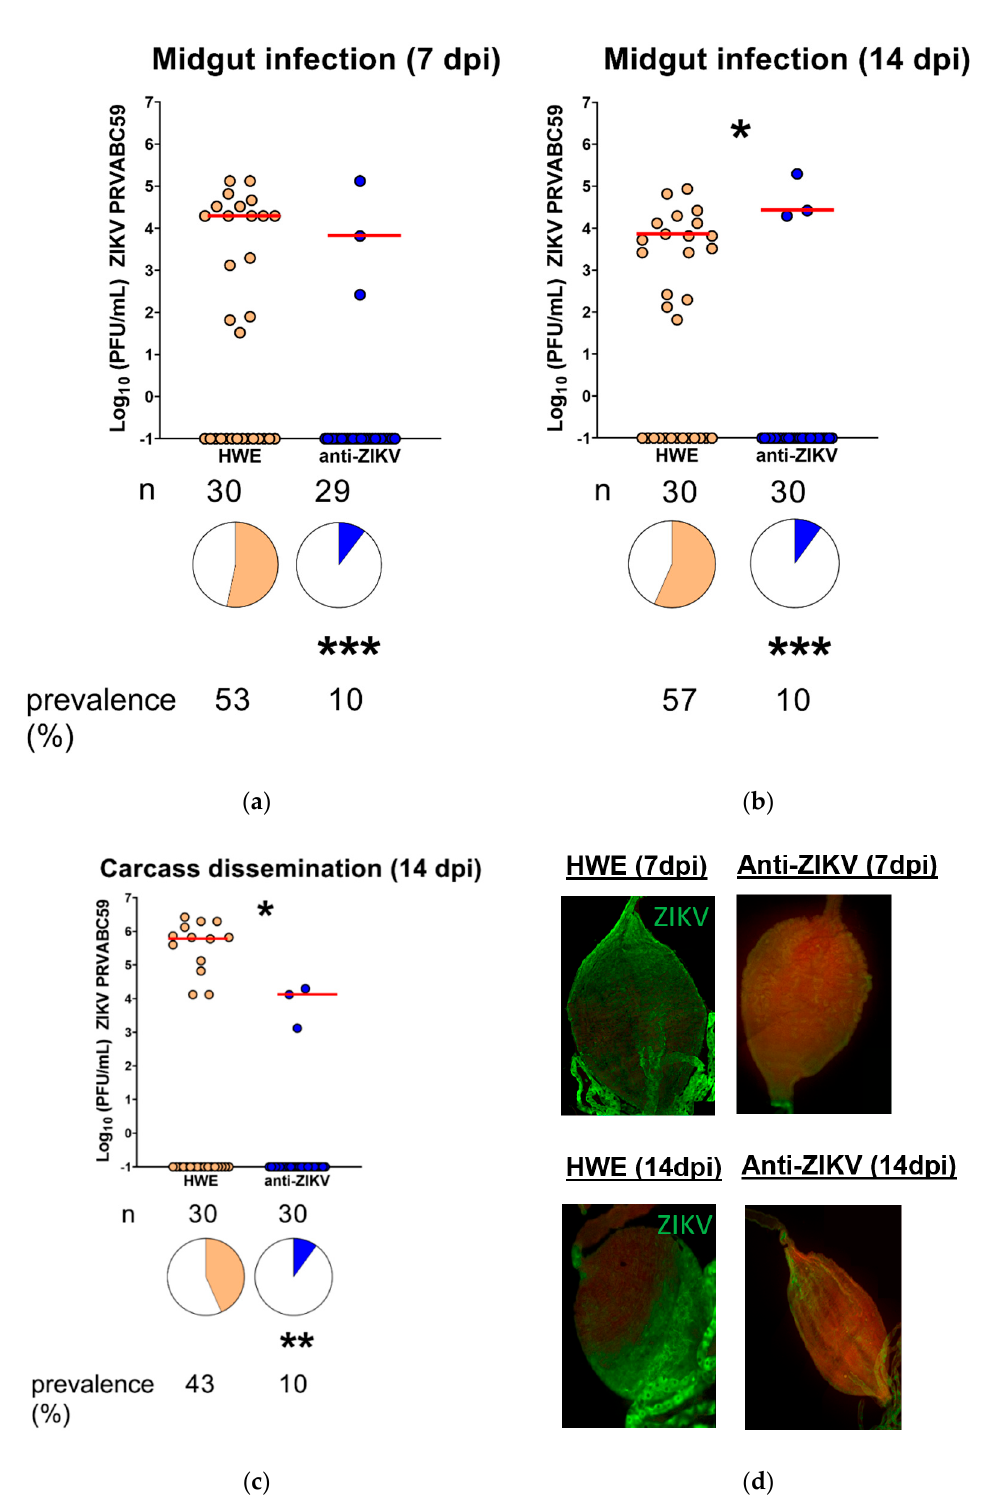
Figure 4. ZIKV IR effector expressing mosquitoes (anti-ZIKV-NS3/4A) are resistant to ZIKV. Infected midguts at ( a ) 7 dpi or ( b ) 14 dpi. ( c ) Infected carcasses showing disseminated infection at 14 dpi. ( d ) Representative immunofluorescence assay images of midguts obtained from HWE and anti-ZIKV-NS3/4A mosquitoes at 7 dpi (top) or 14 dpi (bottom). Primary antibodies recognized the ZIKV E and NS1 proteins. Red bars indicate median virus titers. Stars above graph compare virus titers between infected groups. Stars below pie charts compare infection prevalence; n = number of mosquitoes tested; * = p < 0.05, ** = p < 0.01, *** = p < 0.001. “Anti-ZIKV” = anti-ZIKV-NS3/4A (transgenic) mosquitoes.